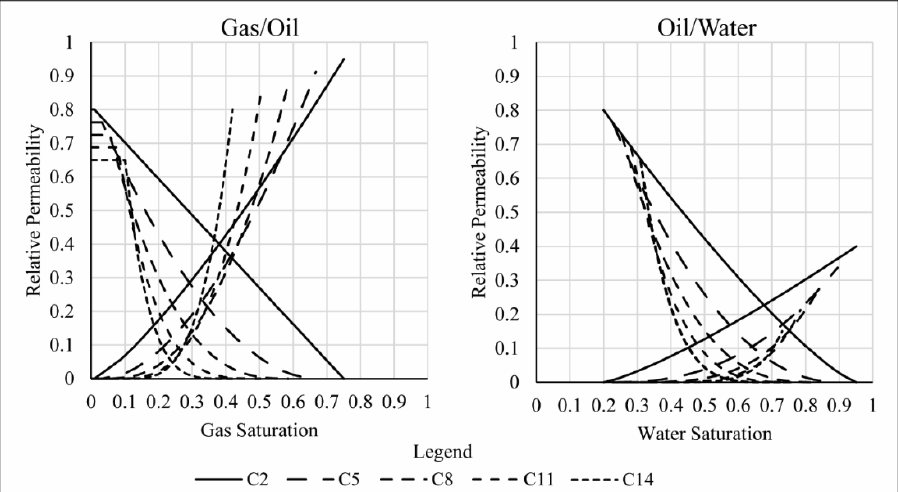
Figure 1. A representative selection of relative permeability curves used in this study. All curves used follow a similar trend of high residual saturation and highly curved to low residual saturation and near linear curve. Only those shown here vary the maximum relative permeability in addition to the other two variables.